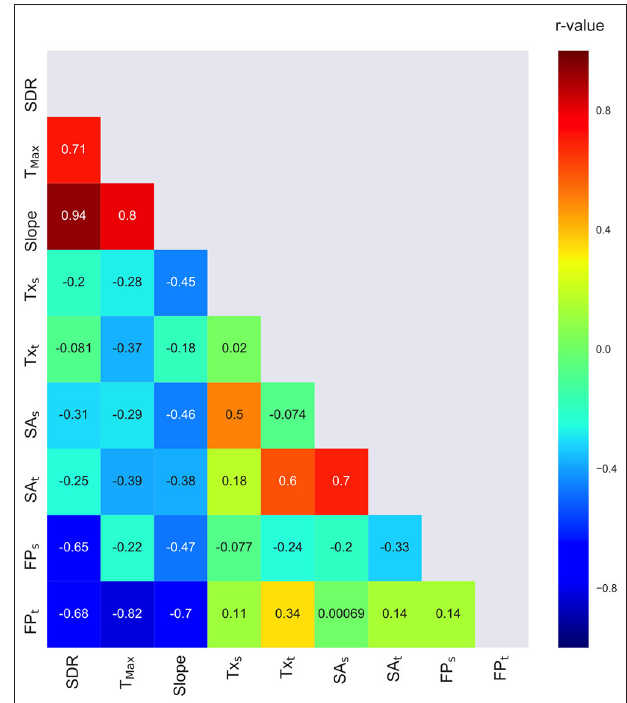
FIGURE 5 | Correlation matrix of patient- and treatment-related data calculated for all patients included in this